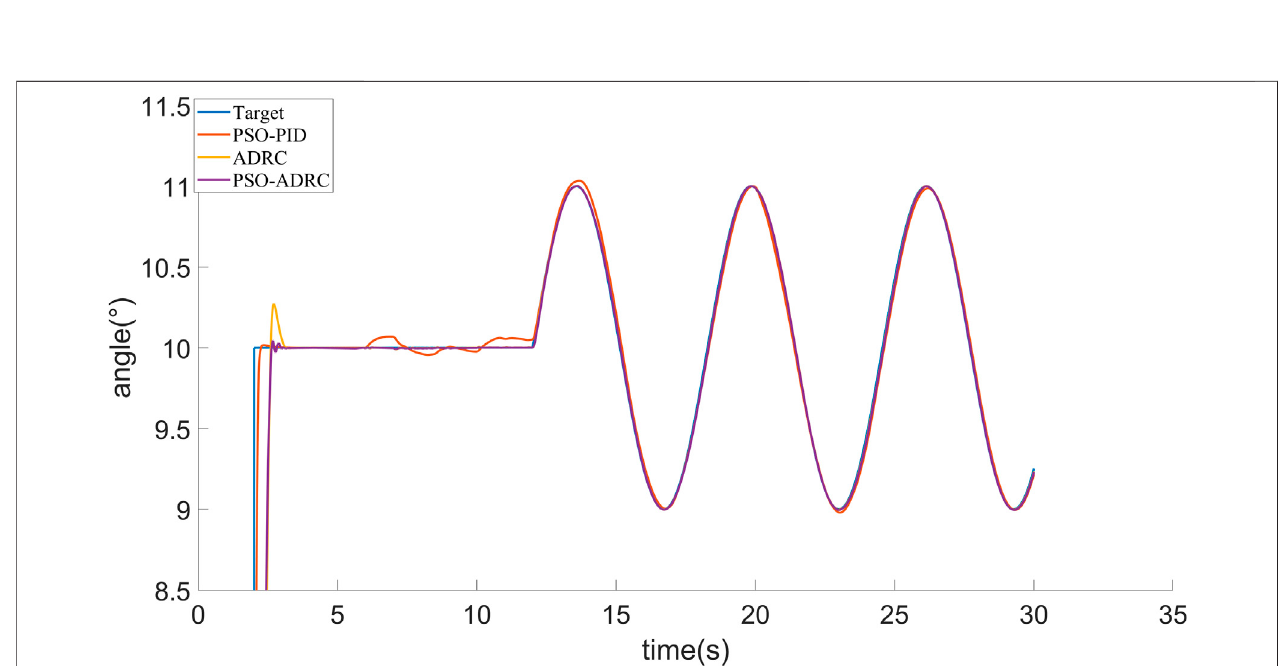
FIGURE 7 | Signal tracking experiment under external